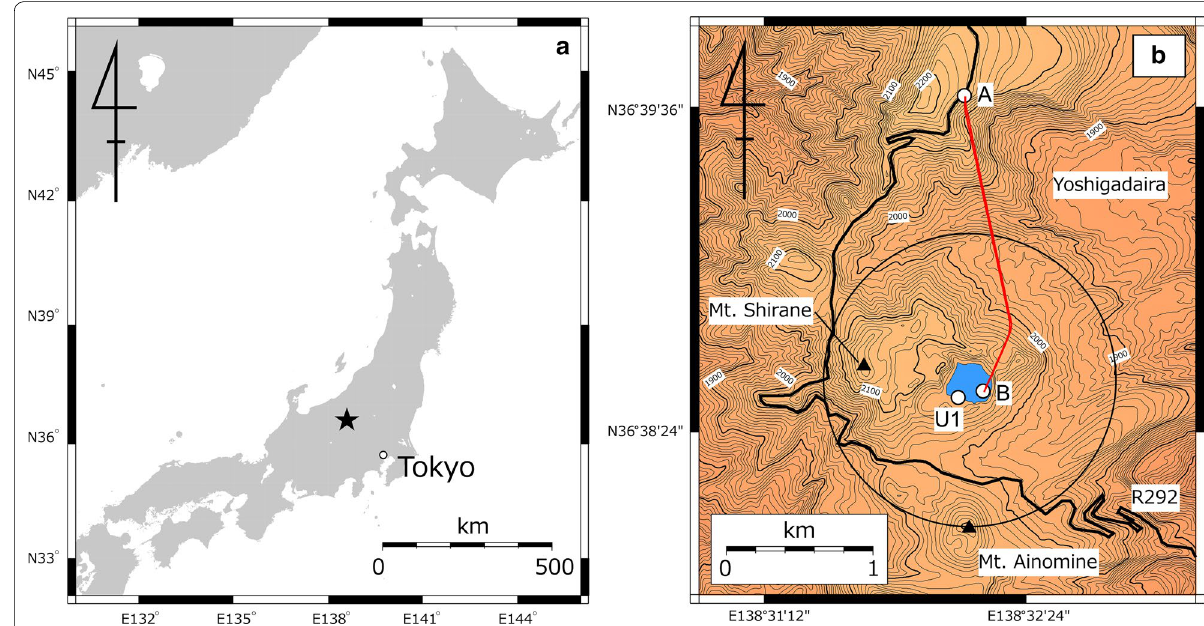
Fig. 1 Location and topography of Kusatsu-Shirane volcano. a Location map of Kusatsu-Shirane volcano within Japan (marked by a star). b Topo- graphic map of Kusatsu-Shirane volcano. Solid lines are topographic contours at intervals of 10 m. “A” and “B” correspond to the takeoff/landing site and water sampling site, respectively. Regular sampling of lake water by hand has been carried out at site U1. Red line indicates the flight route for water sampling on October 18, 2017. The circle indicates a distance of 1 km from the center of Yugama crater